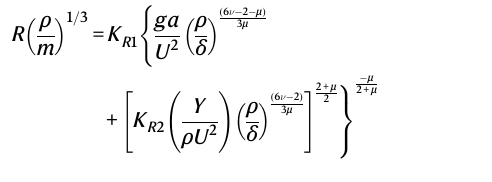
cohesionless (while the boulders have signi fi cant cohesion). The case shown in a corresponds to the one shown in Fig. 1. The crater radius in the case of the homogeneous target is